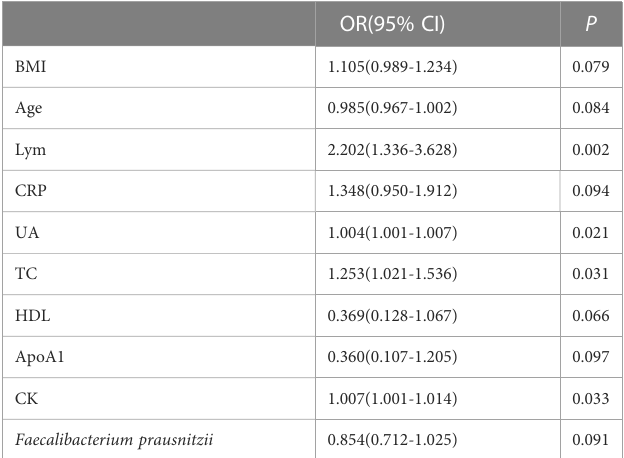
TABLE 3 Single-factor logistic regression analysis of obesity with NAFLD ( P < 0.1).